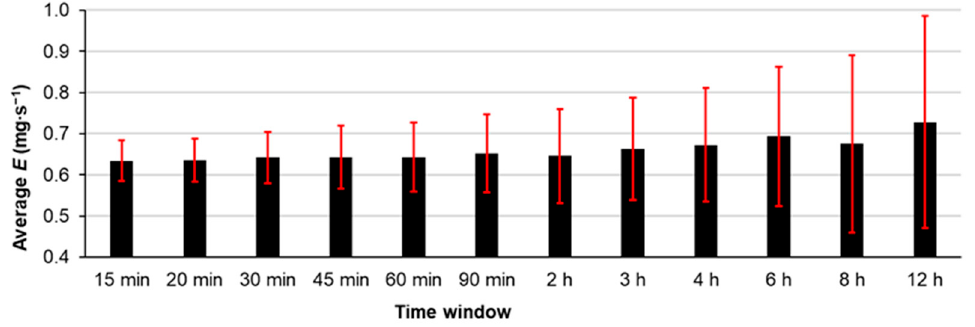
Figure 7. E dependence on the time window width for artificially modified model data (vertical red lines are standard deviation bars).